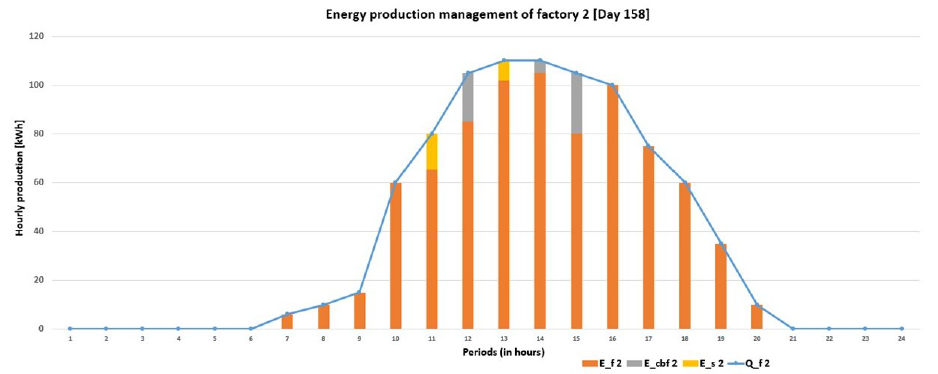
Figure 7. Energy production management of factory 2 during day 158.